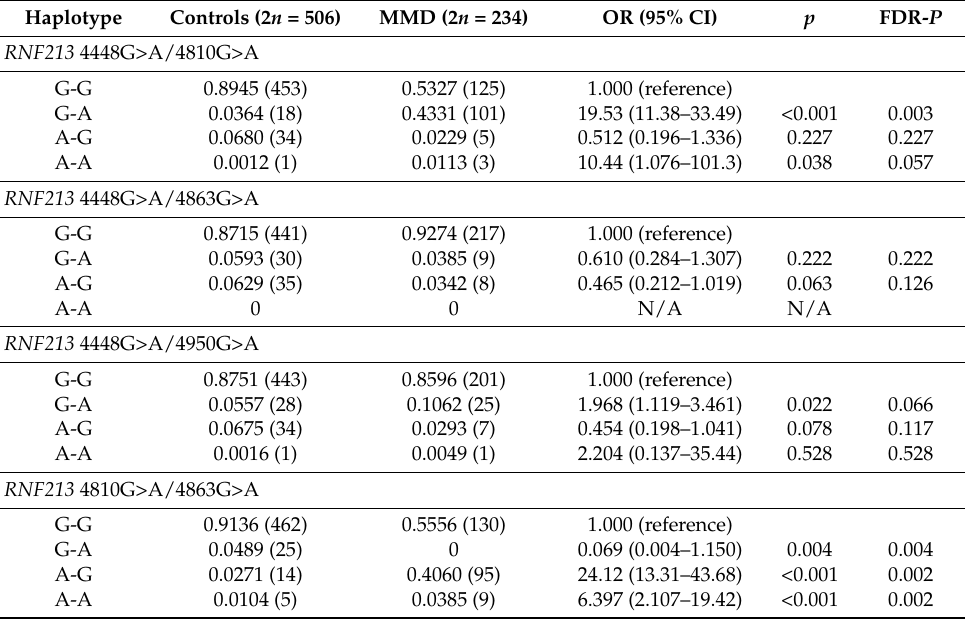
Table 6. Haplotype analysis of RNF213 in MMD patients and control